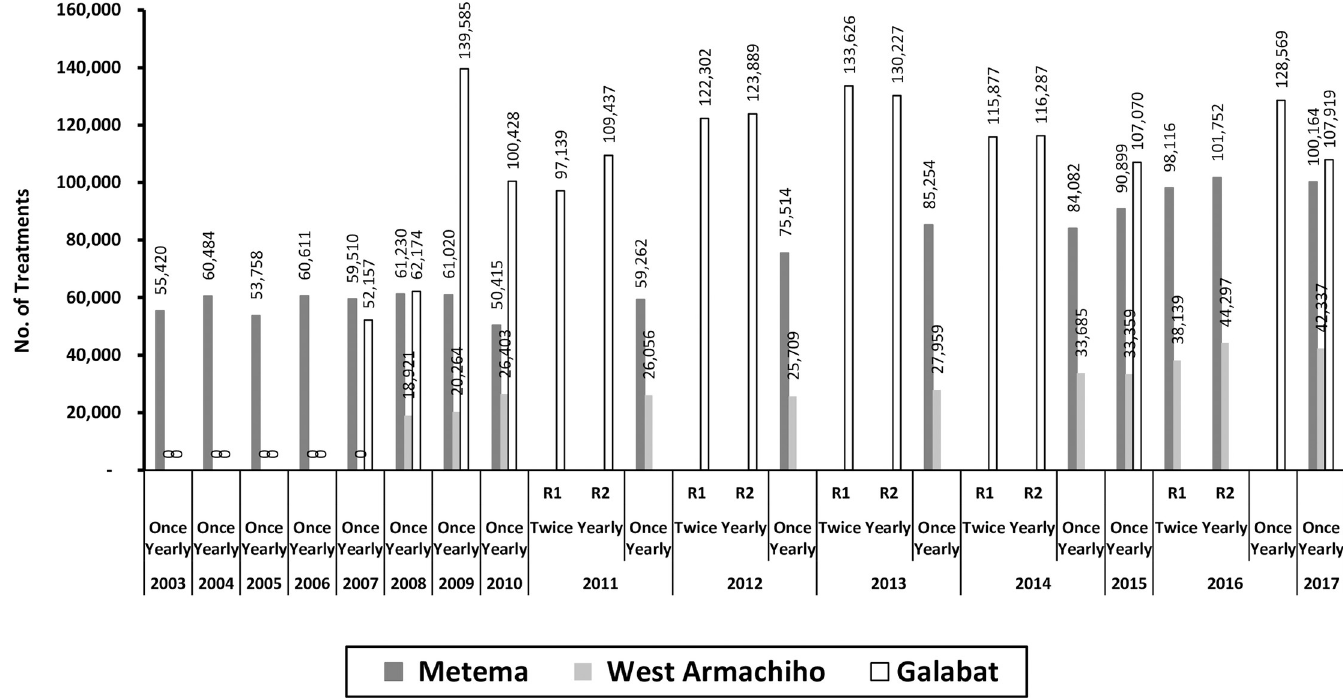
Fig 2. Number of MDA ivermectin treatments provided once or twice yearly in Galabat sub-focus (Sudan) and Metema sub-focus in Metema and West Armachiho districts of Ethiopia) - 2003–2017. Not copyrighted, and was created in Ms Excel.